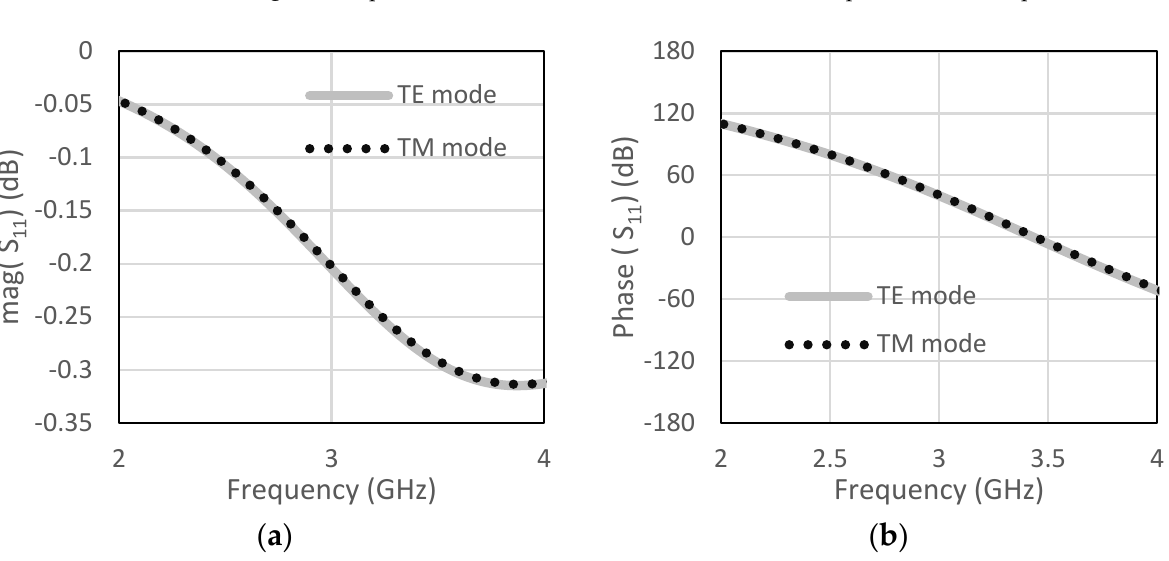
Figure 1. Top view and side view of the unit cell ( a ) circular patch ( b ) circular patch with a ring.